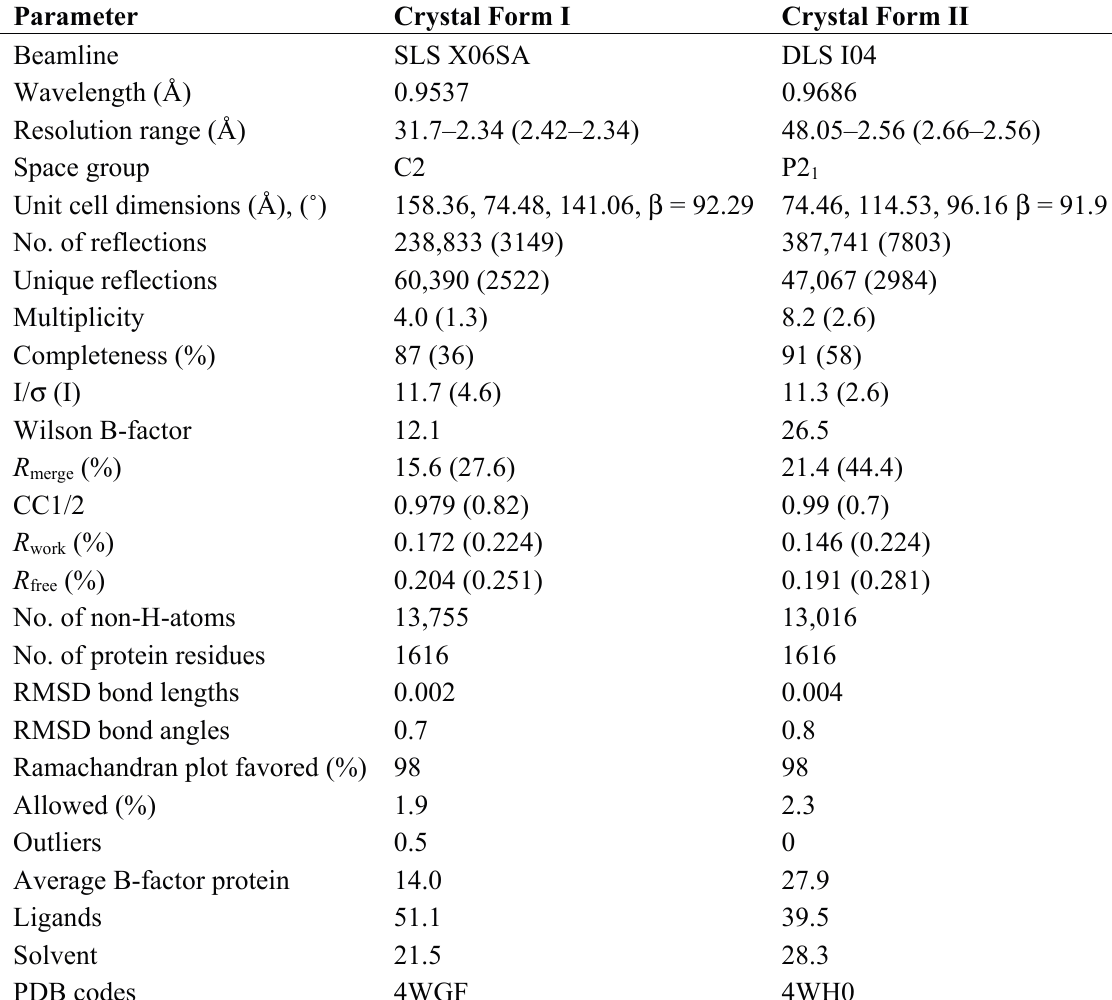
Table 1. Data collection and refinement statistics (numbers in brackets refer to the last resolution shell). The rather low R-factors relative to the resolution are likely due to the